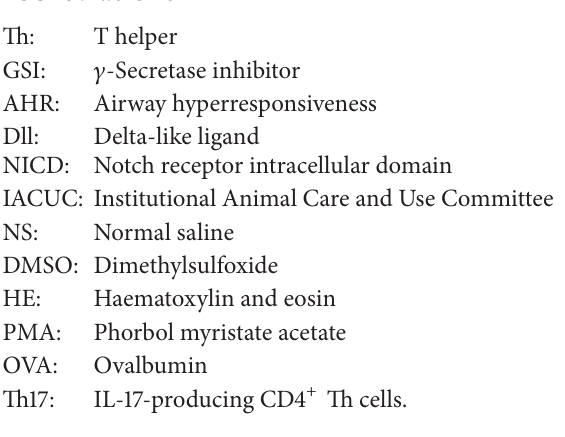
[13]. However, the exact underlying mechanism is yet to be fully